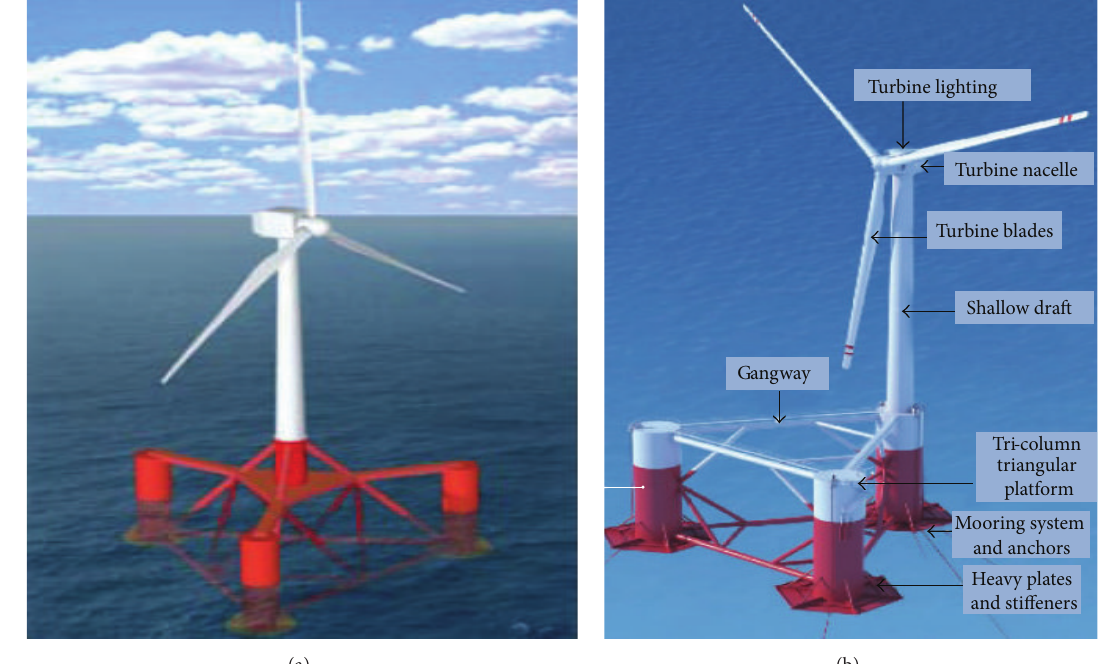
Figure 6: (a) Dutch Tri-Floater [7] and (b) WindFloat semisubmersible concept [8].